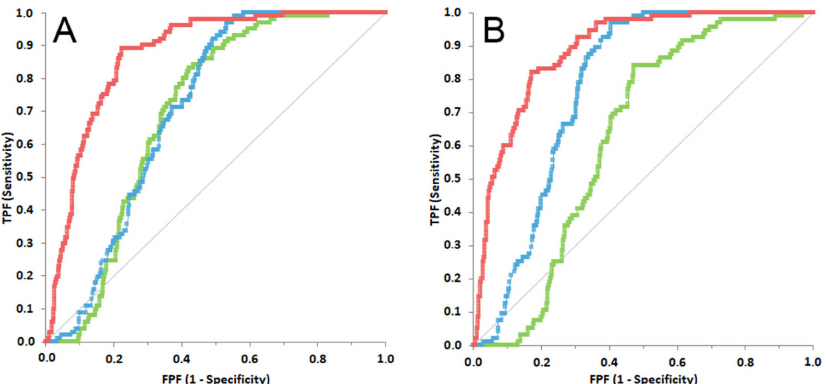
Figure 3. Receiver operating characteristic curve built using the values of LDH/TNCC ratio (in red), LDH (in green) and TNCC (in light blue) calculated based on the results of step 2 (( A ), prob- ability of FIP based only on cytological and chemico-physical analysis of the effusion) or of step 3 (( B ), probability of FIP based on cytological and chemico-physical analysis of the effusion and on additional signalment or laboratory data). The central grey line represents the no-discrimination